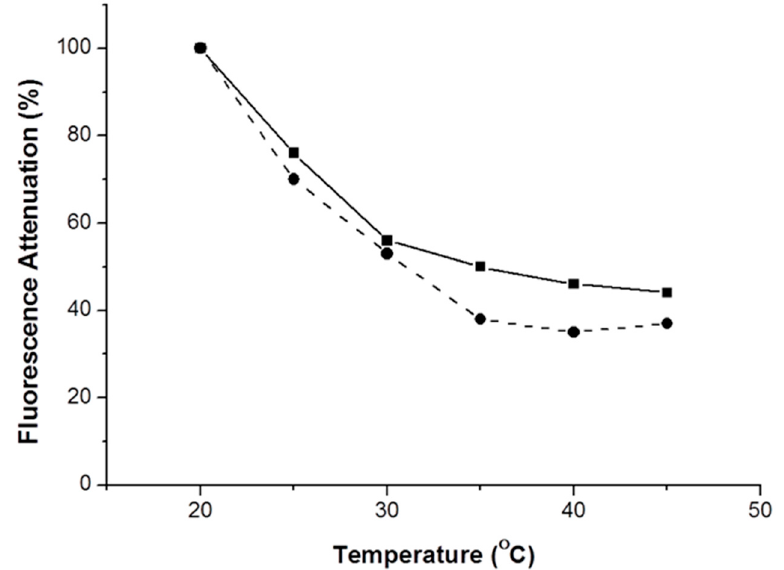
Figure 7. Fluorescence attenuation of the F8T2 ethyl cellulose film with 1% ( w / w ) of PEG 3400 in the absence (solid line) and presence (dashed line) of DNB vapor with as a function of the temperature. Excitation wavelength was 450 nm.